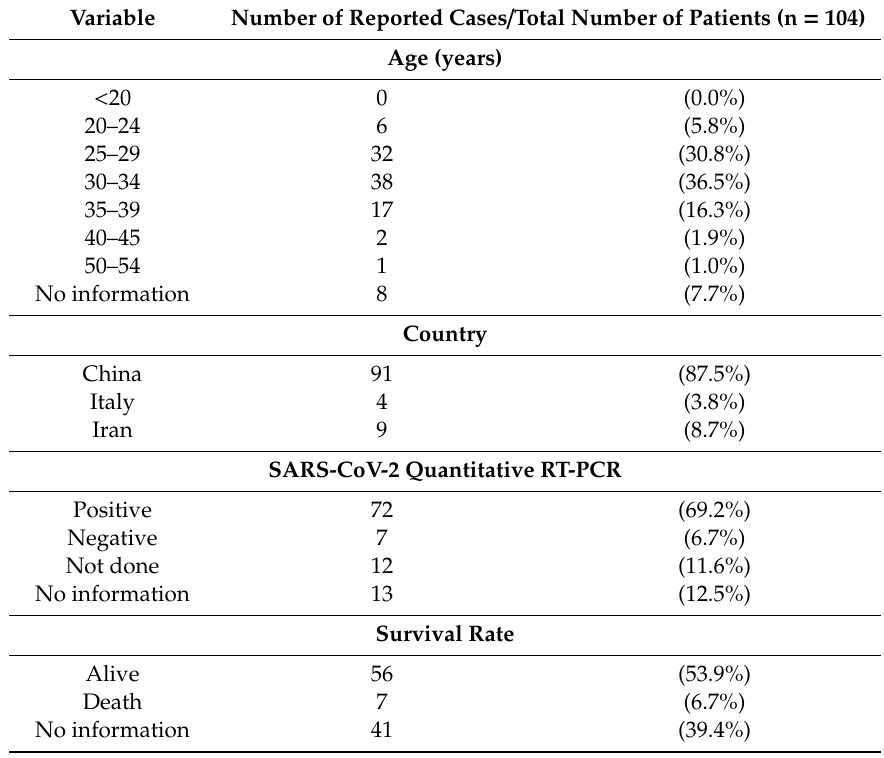
Table 2. Baseline characteristics of pregnant patients with